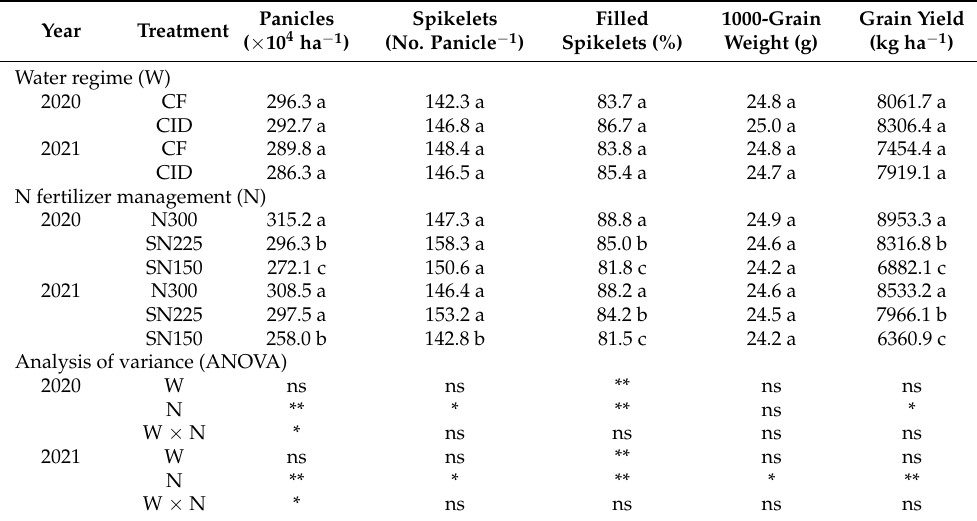
Figure 6. Dynamics of dry matter ( a , c ) and nitrogen ( b , d ) accumulation of above-ground plants of rice in the 2020 and 2021 seasons for various water and fertilizer treatment combinations. TL, JB, HF, and MR denote tillering, jointing–booting, heading–flowering, and milky ripening stages of rice. CF and CID represent continuously flooded and controlled irrigation and drainage, respectively. N300 denotes conventional farmers’ fertilization of 300 kg N ha − 1 without straw return; SN225 and SN150 denote straw return with 225 and 150 kg N ha − 1 fertilizer, respectively. Different letters represent statistical significance ( p < 0.05) based on the LSD test. Table 3. Grain yield and yield components under various water and fertilizer treatments.